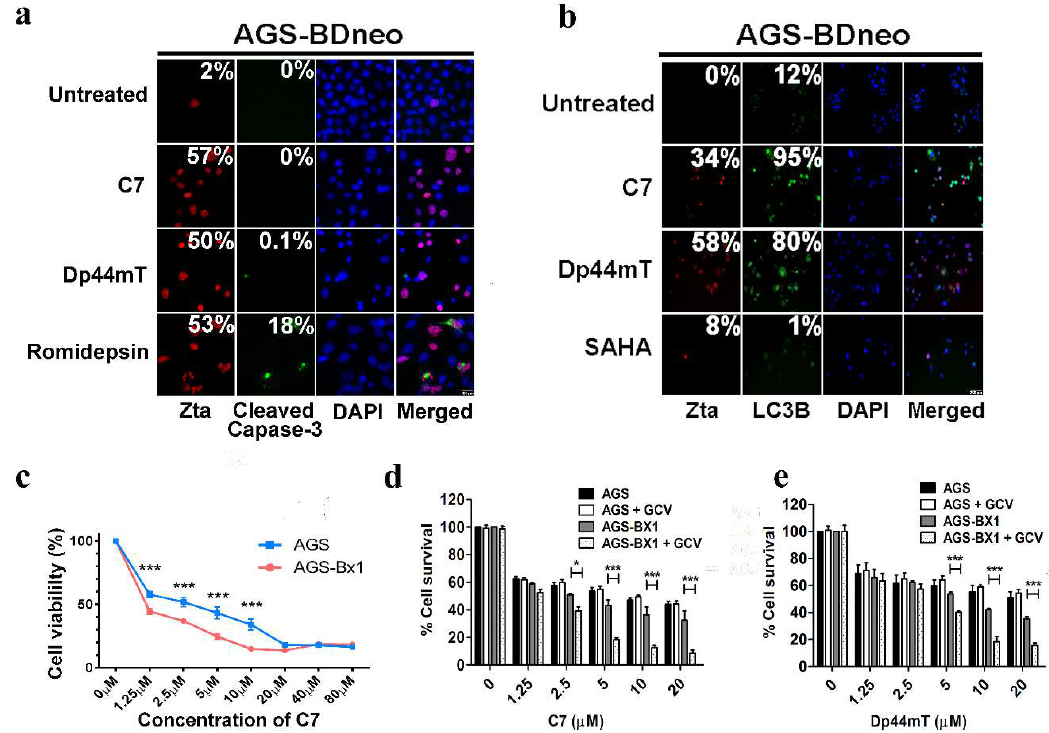
Figure 6. C7 induces cell death via a caspase-independent autophagy-dependent mechanism and both C7 and Dp44mT confer susceptibility of AGS-BX1 cells to ganciclovir. ( a ) AGS-BDneo cells were incubated with either 20 µ M C7, 20 µ M Dp44mT, or 5 nM romidepsin for 48 h. Expression of Zta (red signals) and cleaved caspase-3 (green signals) was analyzed by immunofluorescent staining. DAPI (blue signals) stained cell nuclei. Scale Bar: 100 µ m. ( b ) AGS-BDneo cells were incubated with either 20 µ M C7, 20 µ M Dp44mT, or 10 µ M SAHA for 48 h. Expression of LC3B (green signals) and Zta (red signals) was analyzed by immunofluorescent staining. DAPI (blue signals) stained cell nuclei. Scale Bar: 250 µ m. ( c ) AGS and AGS-BX1 cells seeded in triplicate in 96-well plates were treated with 0, 1.25, 2.5, 5, 10, 20, 40, or 80 µ M C7 for 48 h. An 3-(4,5-Dimethylthiazol-2-yl)-2,5-diphenyltetrazolium bromide